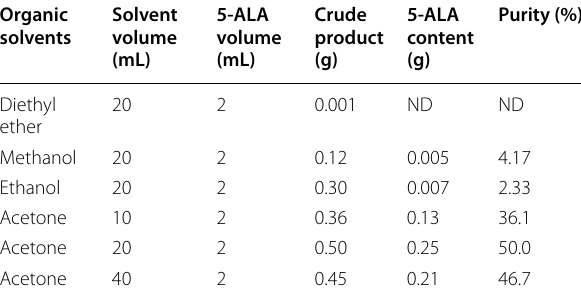
Table 2 The purity of 5‑ALA from different solvents extraction and